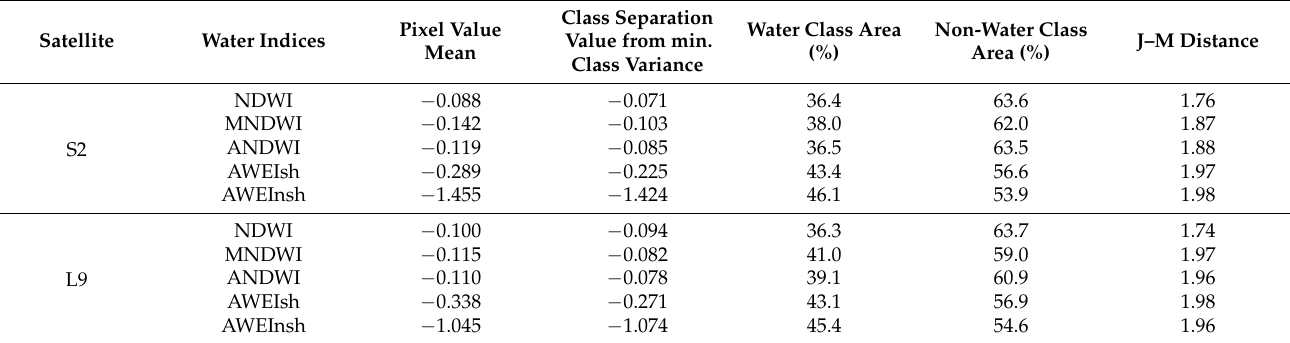
Table 4. Water and non-water class separation index values obtained from Sentinel-2 (S2) and Landsat 9 (L9) satellite imagery estimated from minimum within-class variance criterion. Pixel spatial resolution is 20 m for S2 and 30 m for